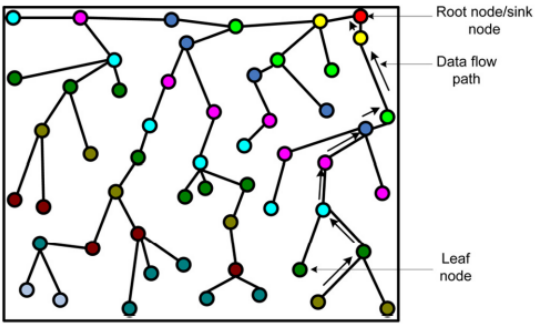
Figure 3. Tree-based WSN (distinct colors are used to represent each tree level).